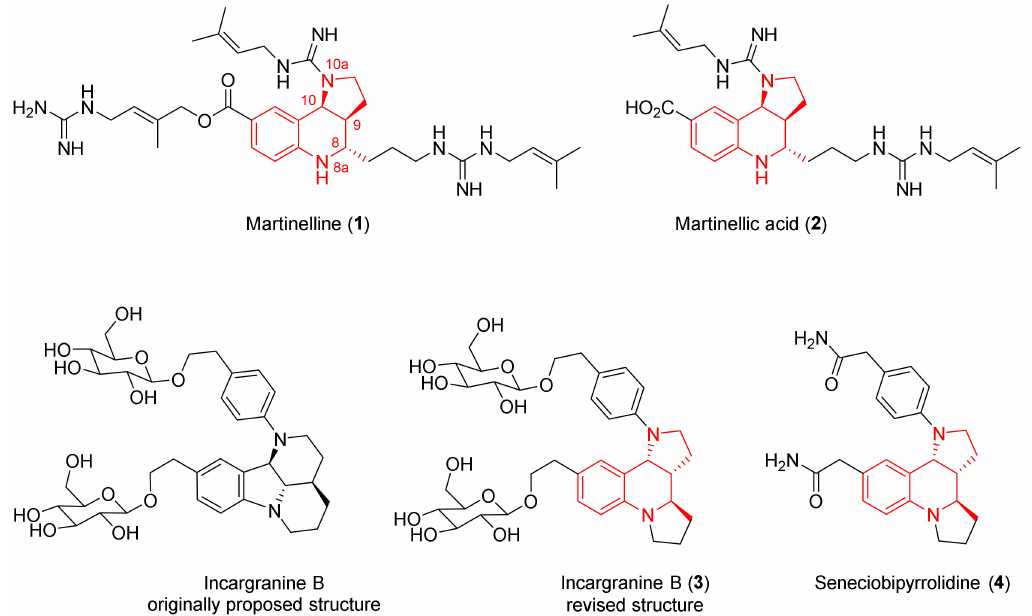
Figure 1. The structure of martinelline ( 1 ), martinellic acid ( 2 ), incargranine B ( 3 ) (originally proposed structure and revised structure), and seneciobipyrrolidine ( 4 ). The pyrrolo[3,2-c] scaffold is highlighted in red with atom